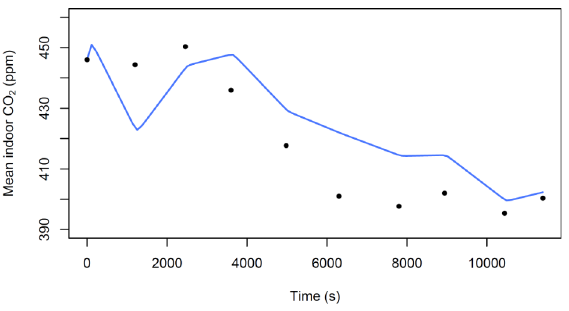
Fig 3. Mean concentration of indoor CO 2 (ppm = parts per million) vs time elapsed since start of data collection (s). The line represents the fitted model from approach 2 and the black dots are the data points.